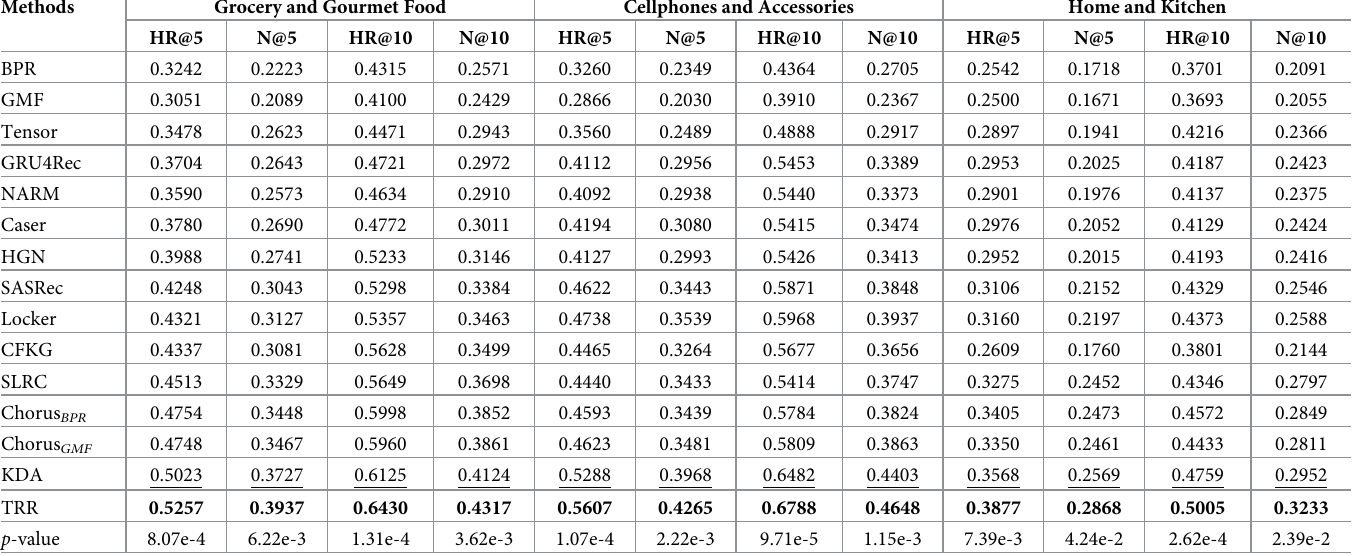
Table 2. The performance comparison of all methods in three datasets. The best performing method of each column is boldfaced. The second best performing method is